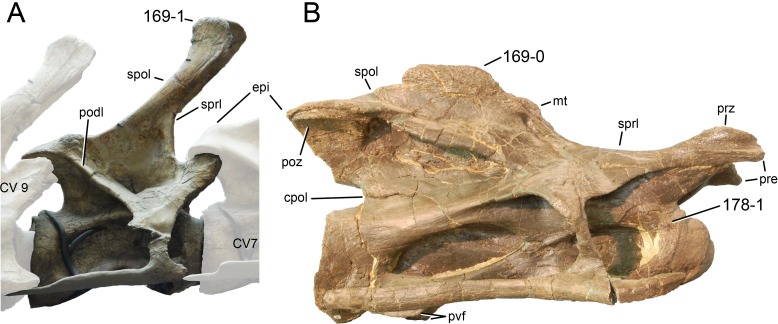
Cervical vertebra 8 of flagellicaudatans.Cervical vertebra 8 of Dicraeosaurus hansemanni MB.R.4886 (A) and Kaatedocus siberi SMA 0004 (B) in right lateral view. Note the different inclinations of the neural spine (C169), and the small tuberosity marking the anterodorsal corner of the centrum in Kaatedocus (B; C178-1). Abb.: cpol, centropostzygapophyseal lamina; CV 7, cervical vertebra 7; epi, epipophysis; mt, median tubercle; podl, postzygodiapophyseal lamina; poz, postzygapophysis; pre, pre-epipophysis; prz, prezygapophysis; pvf, posteroventral flanges; spol, spinopostzygapophyseal lamina; sprl, spinoprezygapophyseal lamina. Scaled to the same cotyle height.